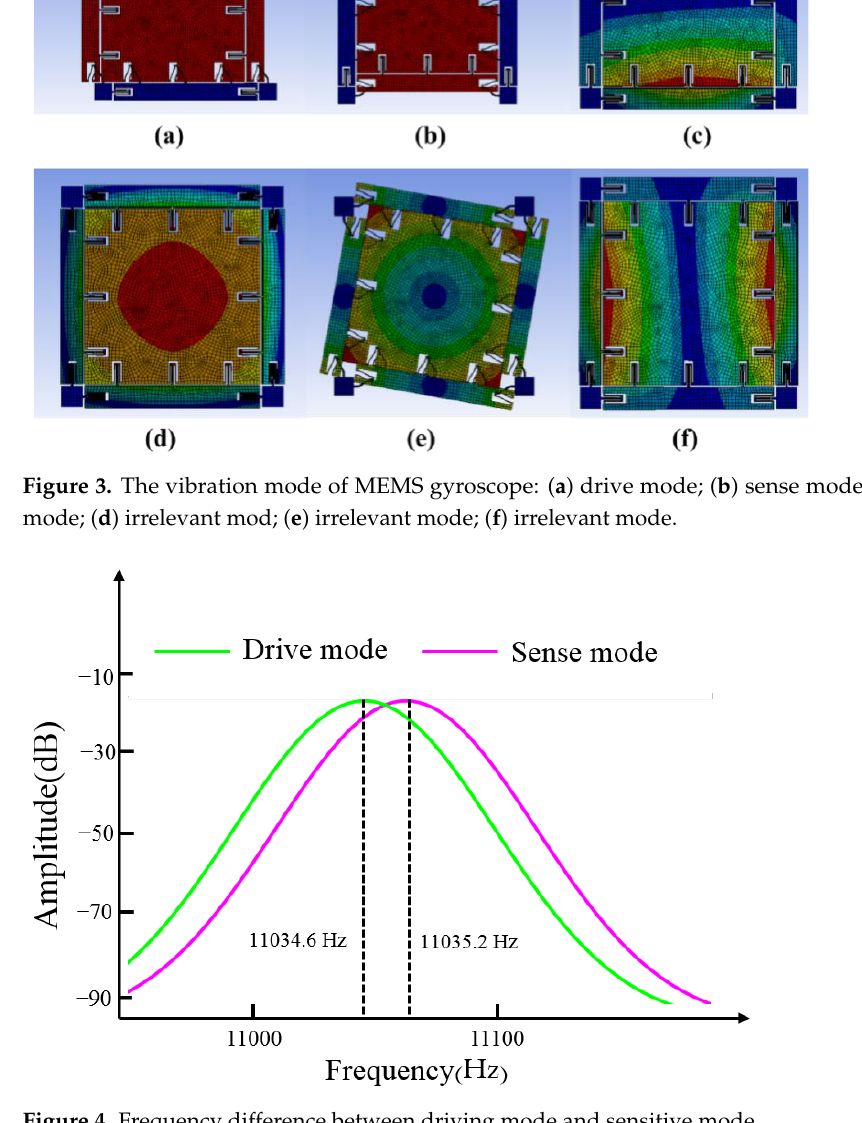
Figure 4. Frequency difference between driving mode and sensitive mode.